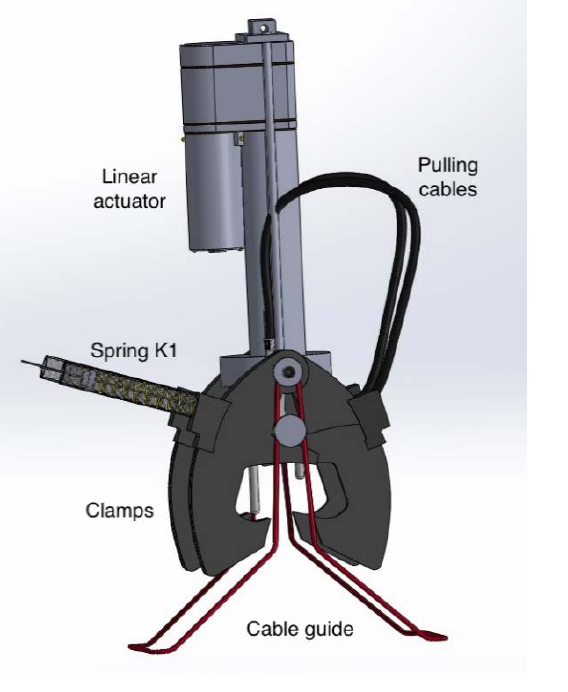
Figure 3. ( a ) Design of the diverter installation tool and ( b ) the current prototype developed.